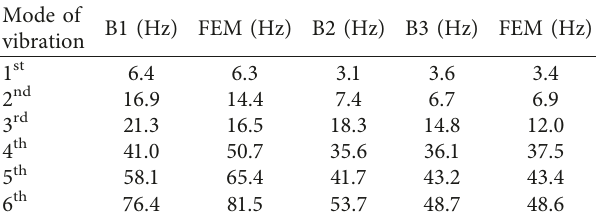
Figure 8: The adopted models for full infill B1 (a) and damaged infill (B2) and consolidated infill (B3) (b). Table 4: Comparison between numerical and experimental